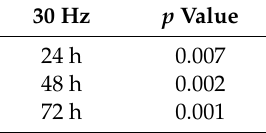
Table 2. The p -value of the percentage of viable CT2A cells after exposure to a 100 µ T EMF at 30 Hz. 30 Hz